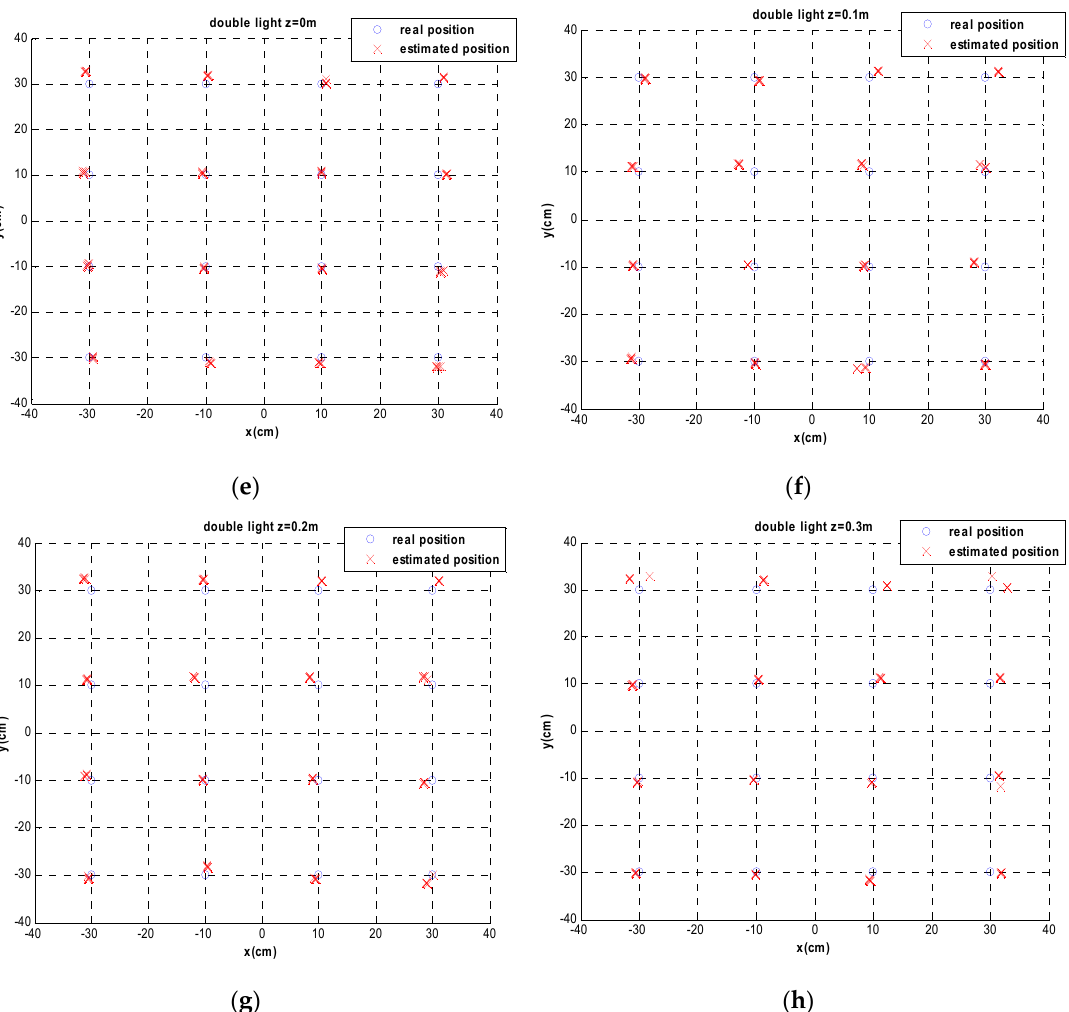
Figure 9. The positioning results of double-light positioning system: ( a – d ) the 3-D positioning results at the height of 0 m, 0.1 m, 0.2 m and 0.3 m, respectively; and ( e – h ) the horizontal view of the 3-D positioning results at the height of 0 m, 0.1 m, 0.2 m and 0.3 m, respectively.